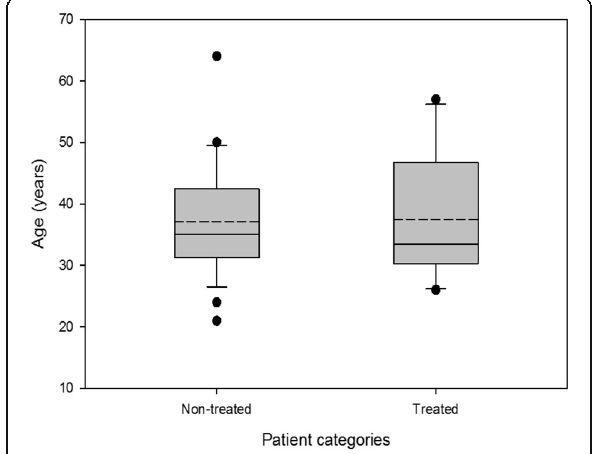
Fig. 1 The descriptive statistics for the age of both non-treated chronic HCV patients (21 to 64 years range with median 35 years) and treated HCV patients (ranging from 26 to 57 years with median 35 years) represented by a box plot constructed in the